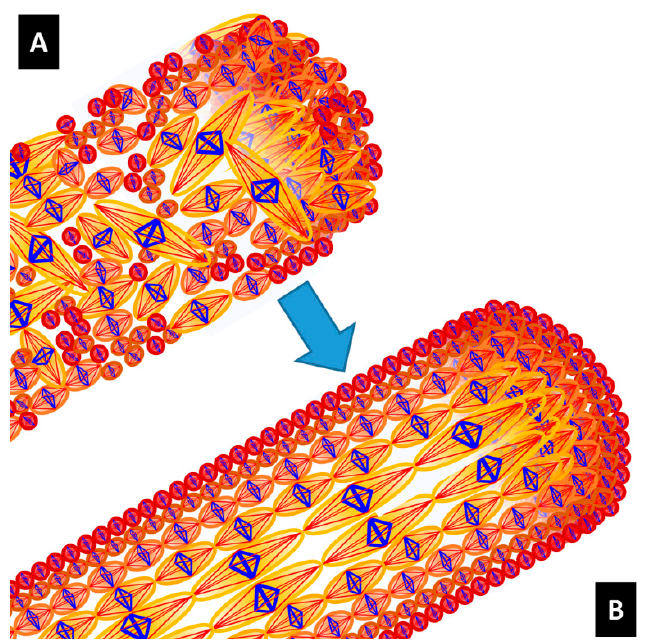
Figure 6. Design of artificial fibres with graded tensegrity architecture ( B ) may enable higher performance space to be accessed, as well as a graded crystalline nanostructure of the fibrils, compared to random structure ( A ).